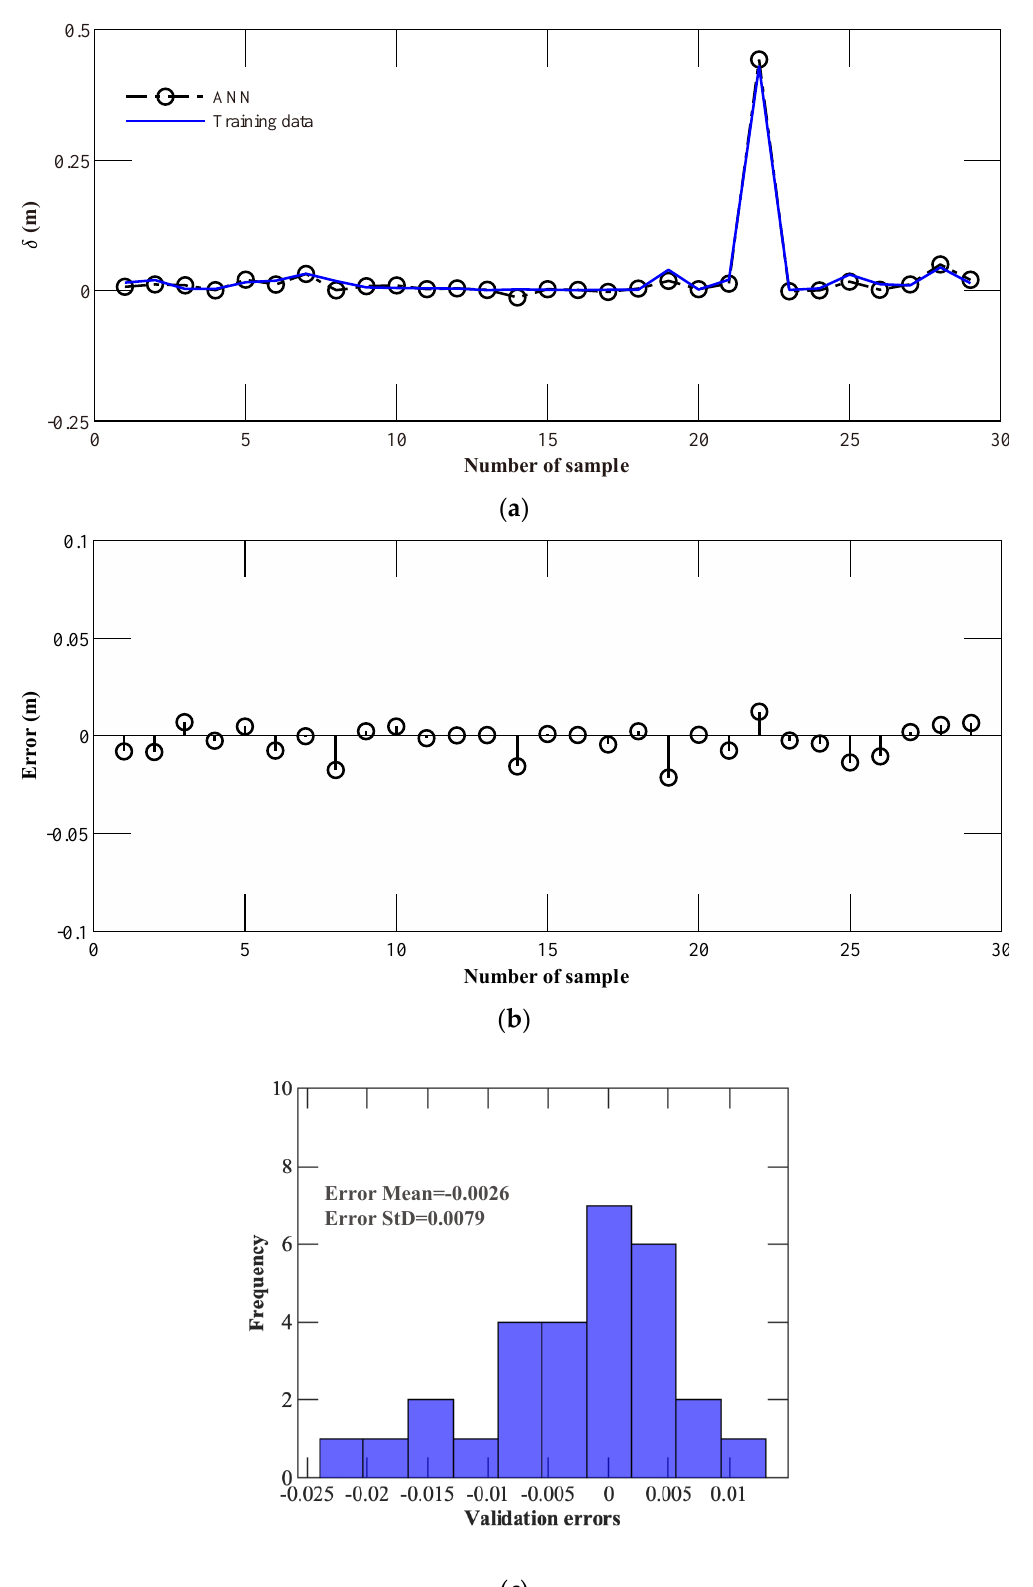
Figure 11. The performance of validation data: ( a ) Predicted versus actual data; ( b ) error; ( c ) the histogram of error values.